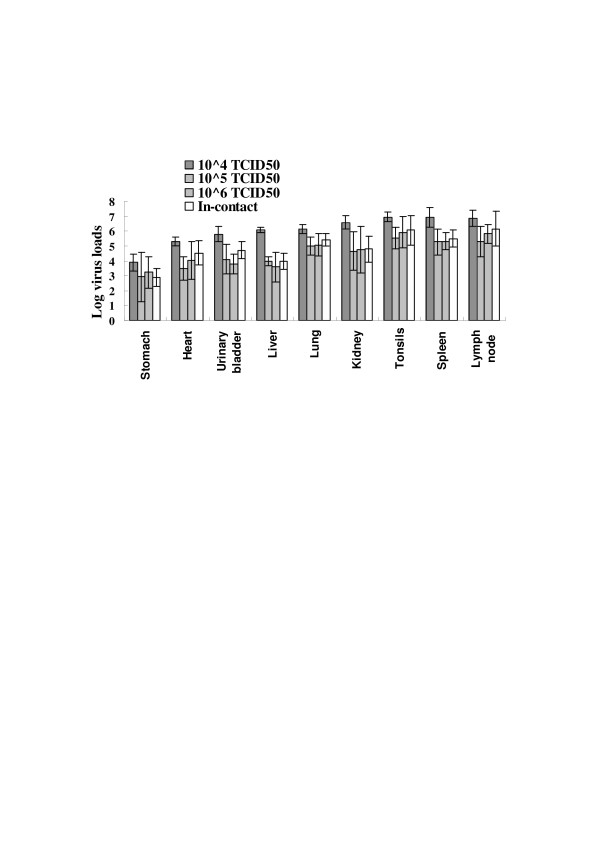
Log number of viral RNA copies from challenged pigs quantified using real-time RT-PCR (copies/μL). Heart, liver, spleen, lung, kidney, stomach, urinary bladder, tonsils and lymph nodes were collected and the distributions of CSFV RNA determined.